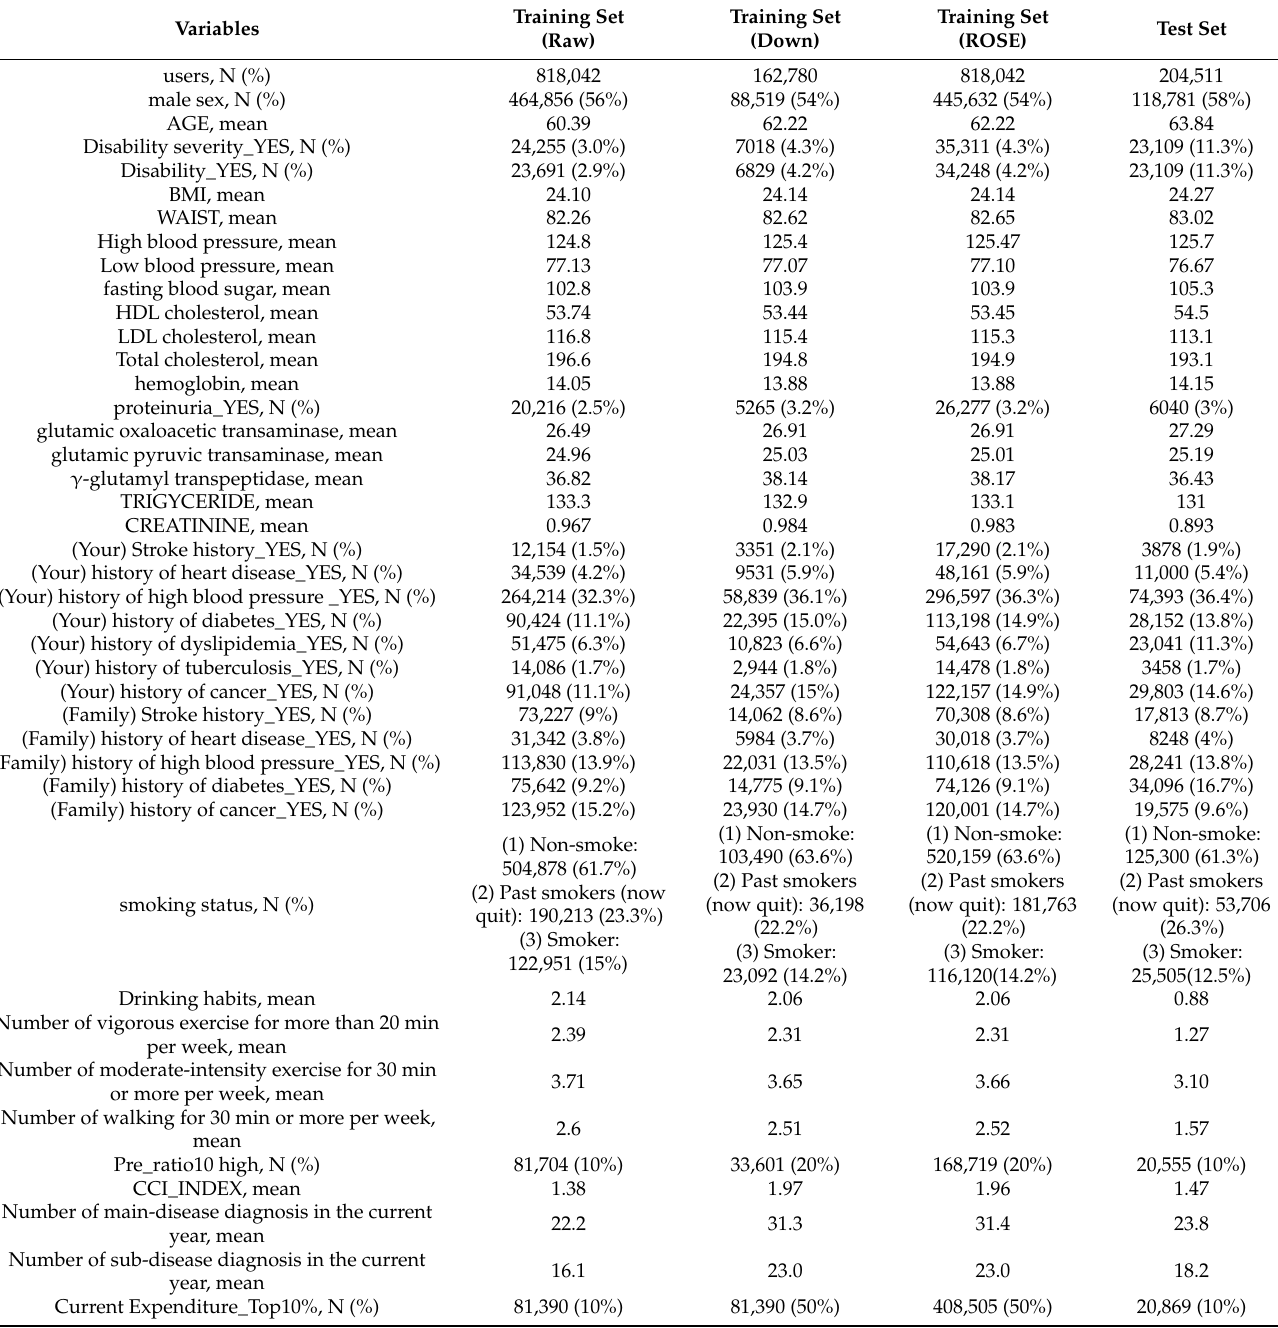
Table 3. Training data set and test set descriptive statistics according to data preprocessing